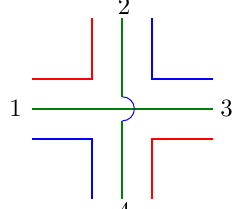
Figure 21. The basic vertices of GW